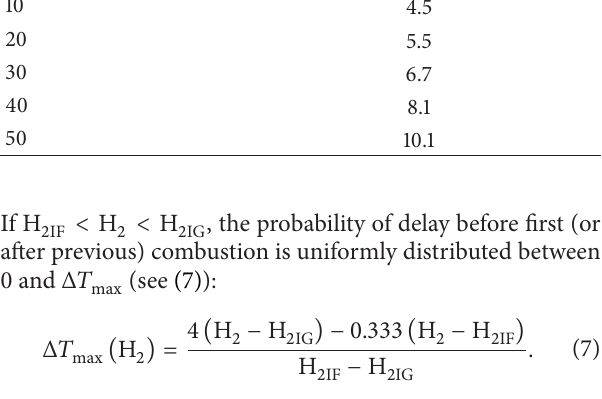
Table 1: Limit for inflammability. O, 2